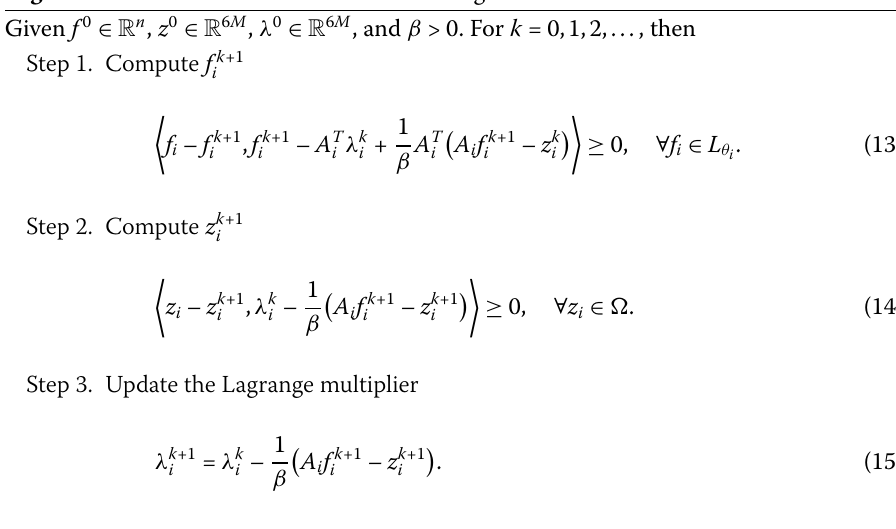
Algorithm 1 The Exact Multiblock Alternating Direction